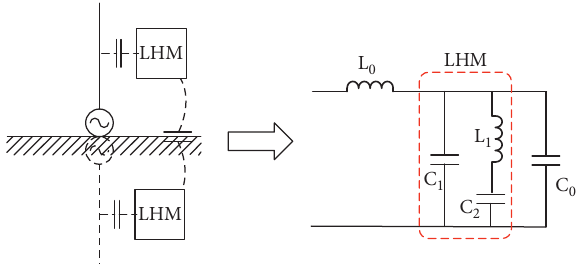
Figure 10: Equivalent circuit of conventional monopole with